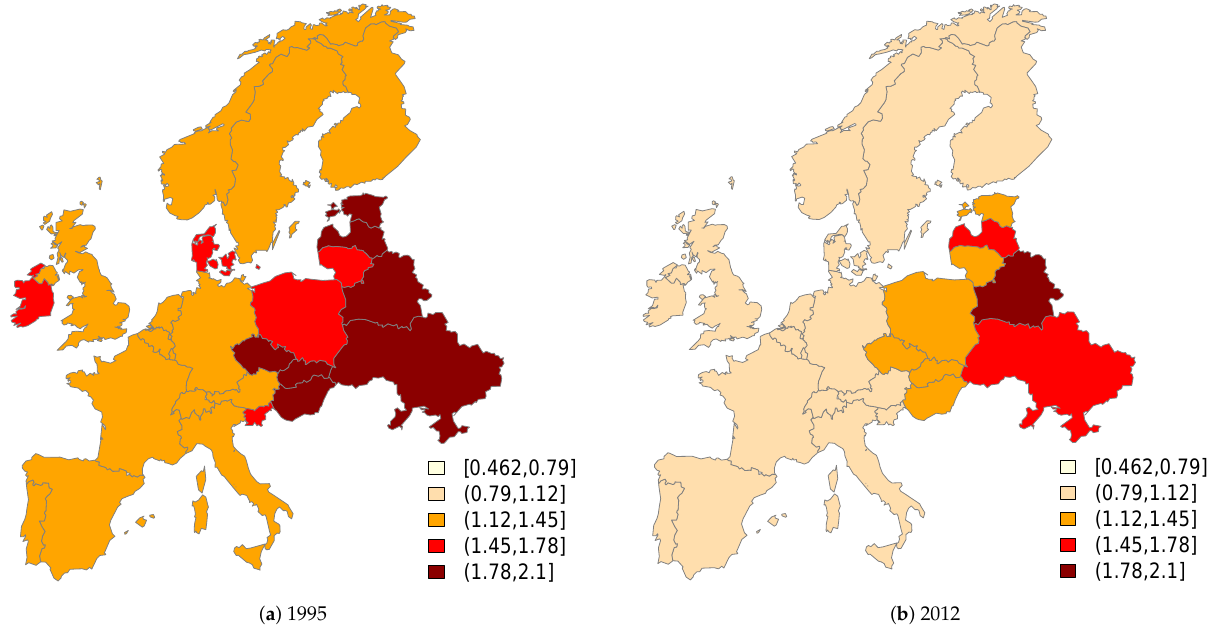
Figure 1. CMF in Europe for 1995 and 2012 for